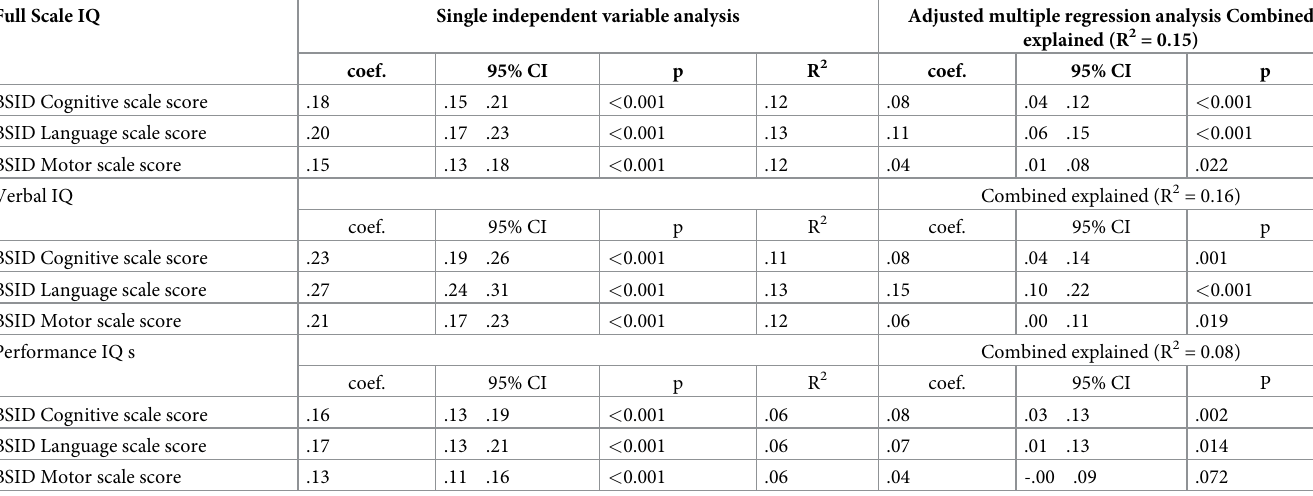
Table 4. Associations between BSID-III composite and the WPPSI III Full scale, Verbal and Performance IQ scores at 4 years in the cohort (N = 1233). Full Scale IQ